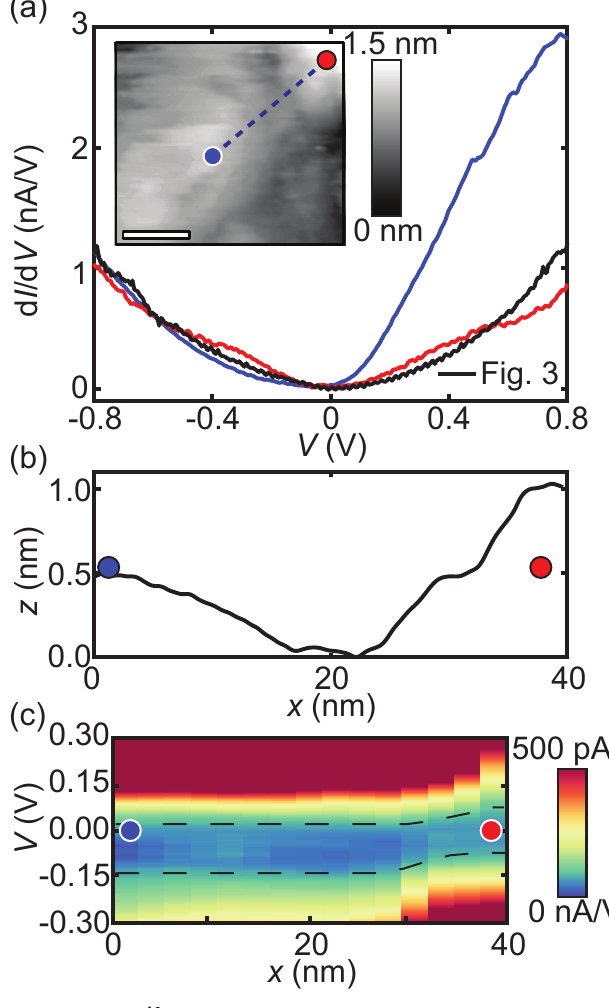
( V ) spectra on the 4-unit-cell-thick BBO film on Nb:STO according to the positions Figure 4. ( a ) d I d V (blue and red dot) marked in the inset. The black curve is taken from Figure 3c (the lower region) and rescaled based on the tunneling parameters. Inset: Topography image (80 × 80 nm, scale bar 20 nm) with the spectrum locations marked. The tunneling parameters are 400 pA and − 1 V. ( b ) Cross-sectional height profile from corresponding blue dashed line in (a), a height variation of ( V ) cross-section recorded across a transition region (blue dashed maximum 1 nm is observed. ( c ) d I d V line in the inset of ( a